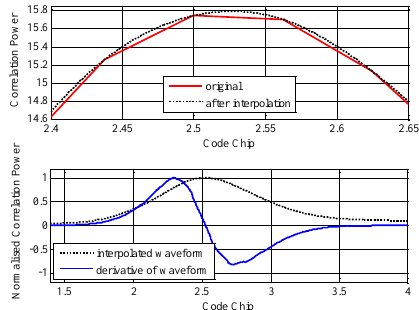
Figure 3. Interpolation of delay waveform (top) and derivative of delay waveform